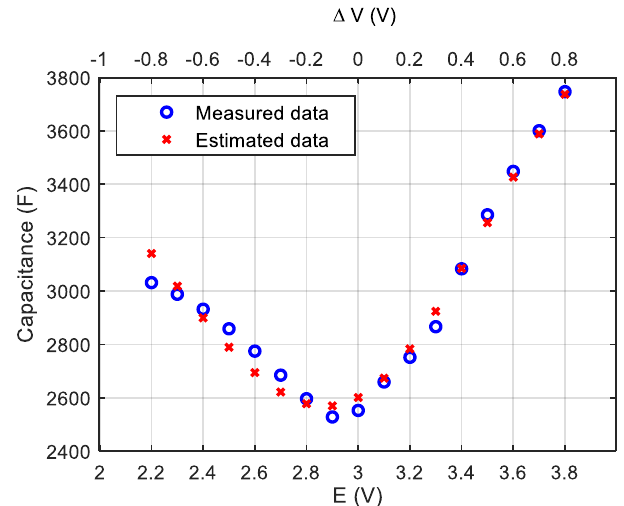
Figure 4. Comparison of the experimental data and the estimated values of the capacitance using the modified Stern model.